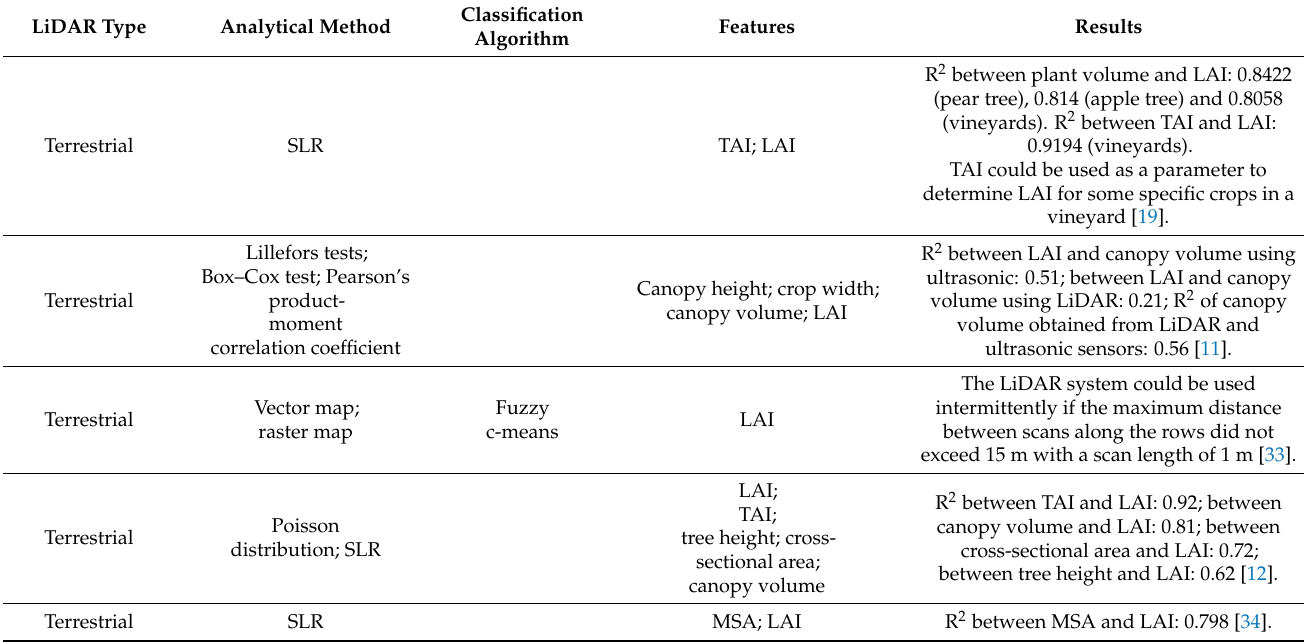
Table 2. Comparison of various aspects of LiDAR data in measuring leaf area index and canopy